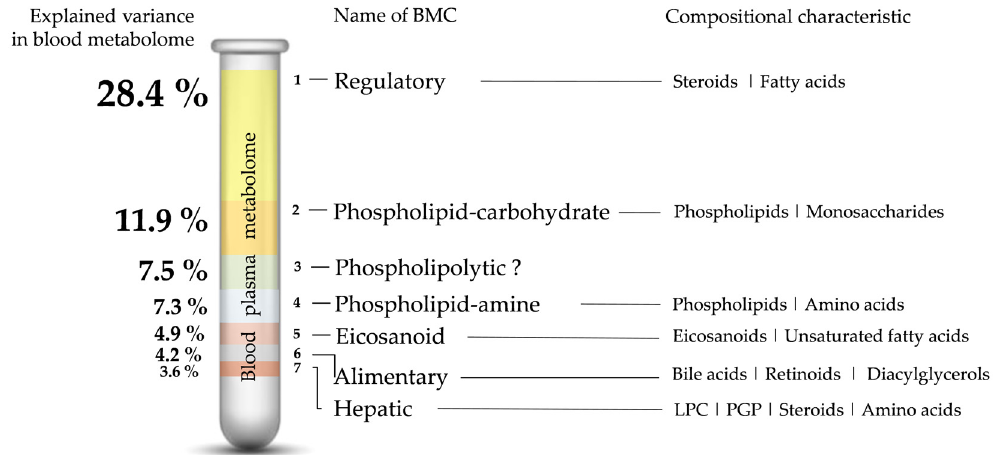
Figure 3. The main blood metabolome components (BMCs) and the main chemical classes that contribute to them. The first seven components are shown, each explaining at least 3% of the variance in the blood plasma metabolome and 68% altogether. The percentage shows the variance explained by BMC. Gender, age, and biological rhythms (for example, circadian rhythm) contributing to metabolome variability are not included (only men of the same age in the study cohort). PC, phosphatidylcholines; LPC, Lysophosphatidylcholines; PGP, glycerophosphoglycerophosphates.